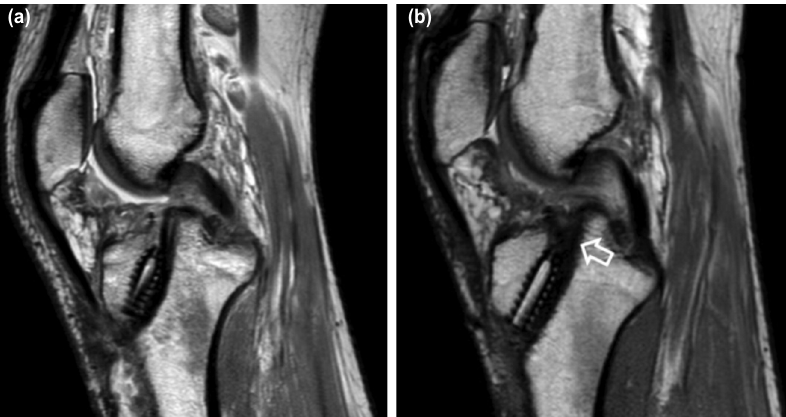
MRI images of tibial tunnel with graft in situ of a participant. (a) Pre-ESWT with no incorporation and, (b) was the post-ESWT Fig. 2: that demonstrates partial incorporation (open arrow).